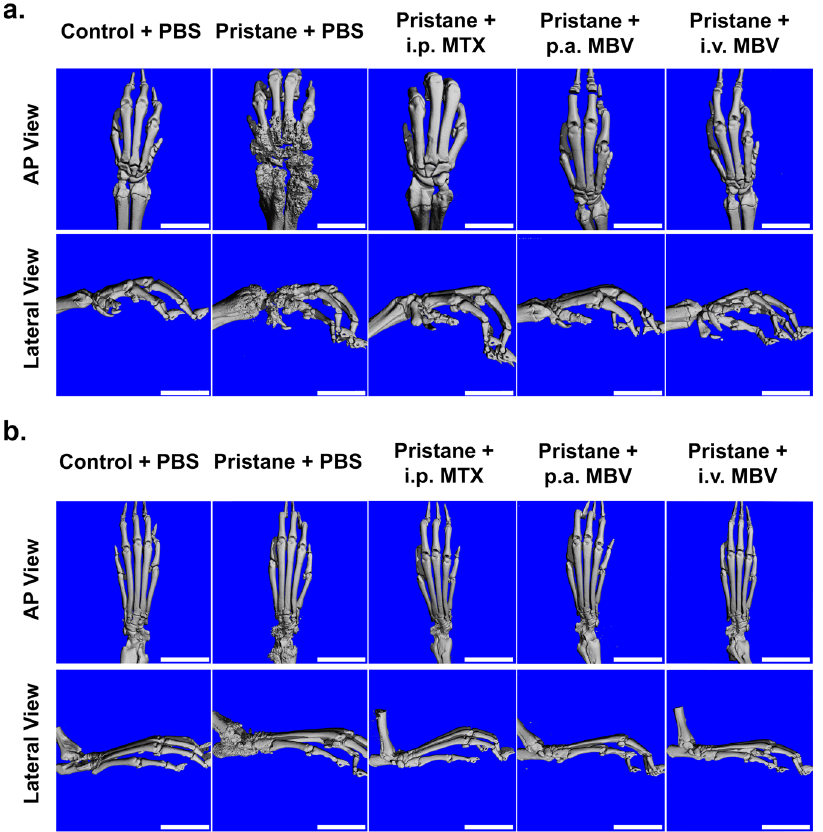
Fig. 2 Systemic and local administration of MBV prevents adverse bone remodeling in chronic pristane-induced arthritis by microCT imaging. a Representative microCT images of forepaws at day 100. Substantial bone remodeling and damage are seen in the pristane + PBS group throughout the proximal bones of the forepaw while all three treatment groups show minimal to absent changes in bone morphology. Scale bar = 10 mm. b Representative microCT images of hind paws at day 100. Substantial bone remodeling and damage is seen in the pristane + PBS group localized to the tibiotalar joint while all three treatment groups show minimal to absent changes in bone morphology, especially in the region of the tibiotalar joint. Scale bar = 10 mm. Both panels a. and b. include both anterior – posterior (AP) and lateral